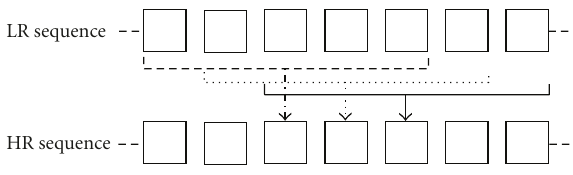
Figure 1: Illustration of the SR reconstruction of all frames in the